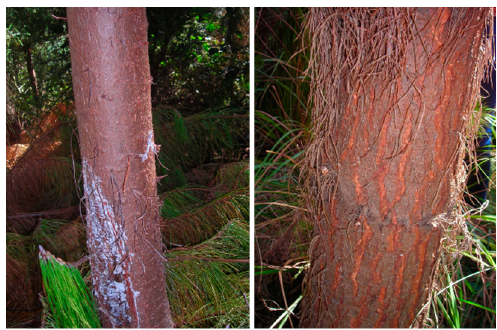
Figure 2. Smooth ( left ) and rough bark ( right ) of a 4-year-old Pinus radiata .